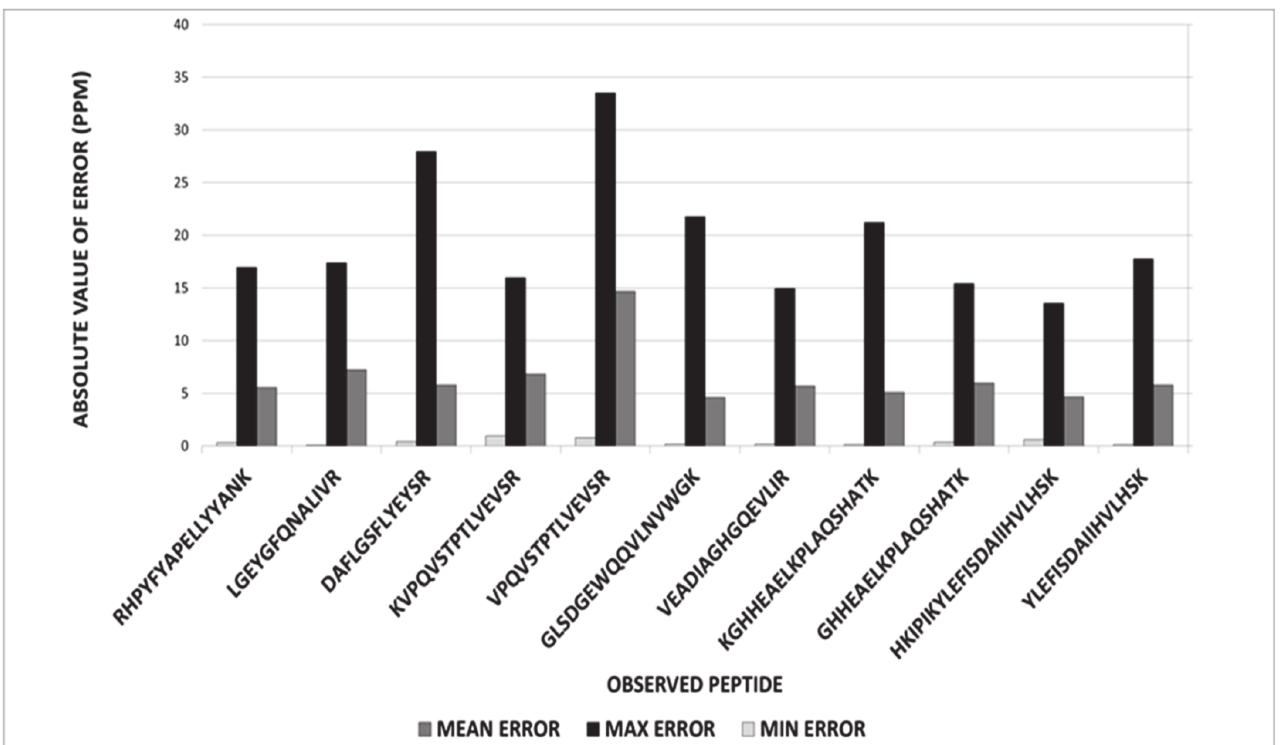
Fig 1. Absolute values for mean, maximum and minimum errors observed for peptides from a standard protein trypsin digestion demonstrate higher variability in the more inaccurate data. Measured errors were converted to absolute values to evaluate the dispersion of data measurements and plotted according to peptide. The uneven distribution of maximum and minimum errors is expected because of zero as a lower bound for minimum error. Note, absolute value transformation of the data eliminates negative values and the mean errors reported here are higher than the mean reported for the observed peptide masses, which contain both positive and negative